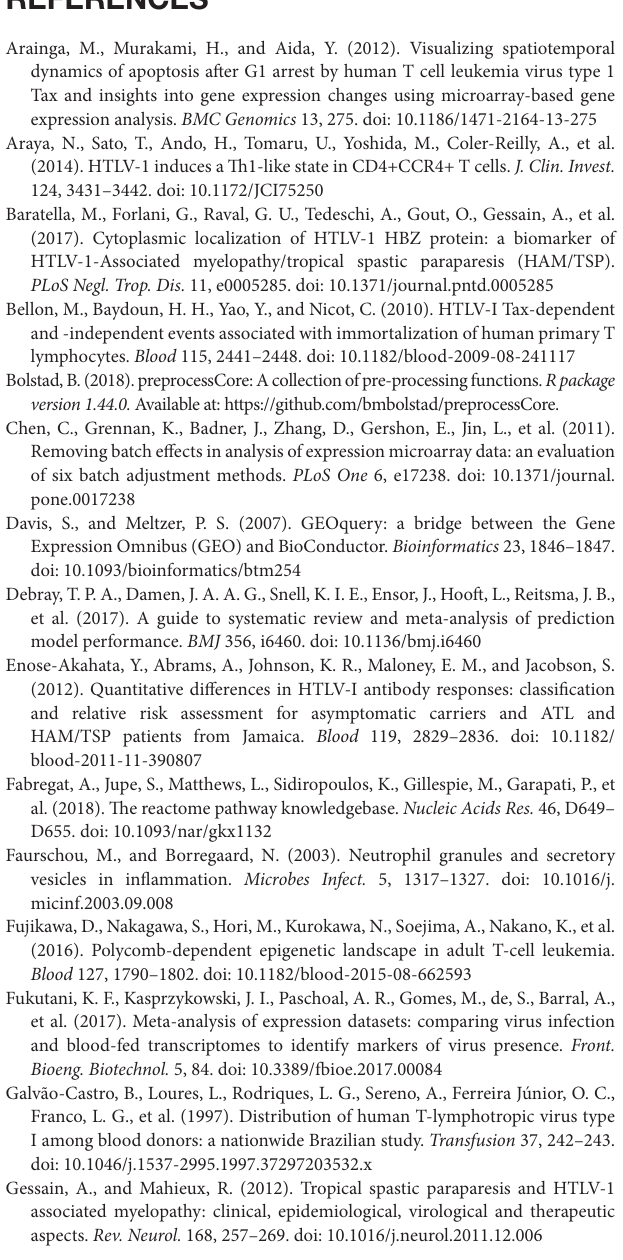
FIGURE S1 | Correlation network based on gene expression values in ATLL samples. Highlighted genes were found to correlate with both CD40LG and GBP2. B - Correlation network based on the gene expression values in the HAM/TSP group. Highlighted genes were found to correlate with both CD40LG and GBP2. C - Correlation network based on the gene expression values in the control group. FIGURE S2 | Scatterplot of validation datasets sample distribution using the CD40LG and GBP2's log transformed expression values. The samples can be separated by symptomatology [ATLL (green), HAM/TSP (red) and control (blue)], this separation is shown by the collored ellipses. The GSE19080's scatterplot has only GBP2 within the dataset, the values of X and Y axis are both representing GBP2's log transformed expression